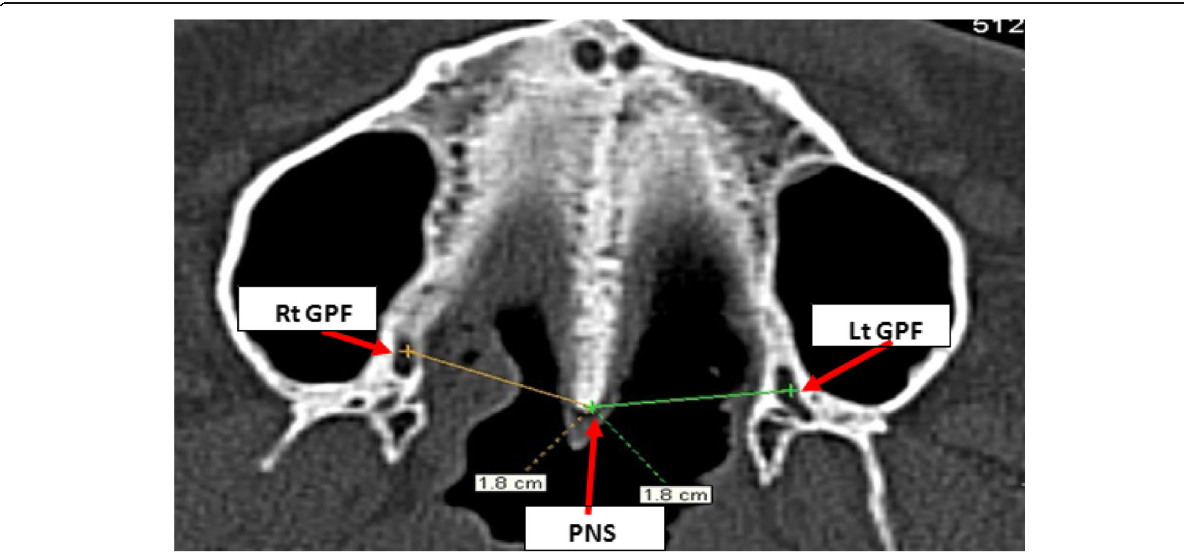
Fig. 11 A CT scan at the region of hard palate illustrating the distance from the center of greater palatine foramen (GPF) to posterior nasal spine (PNS)